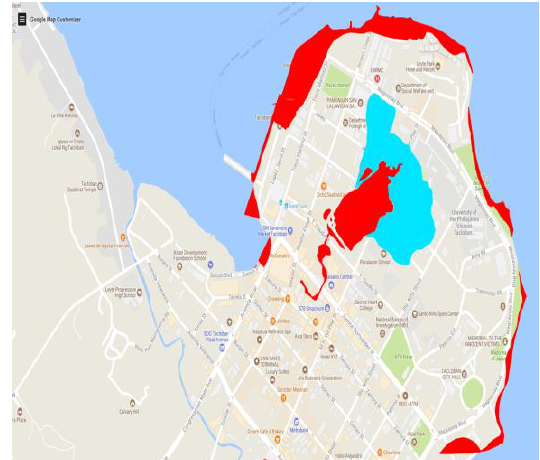
Figure 12. Trace of validated changes in Tacloban City. In the interior: Red - vanished bodies of water, Blue - reclaimed land. Along the coastline: Red – reclaimed land.